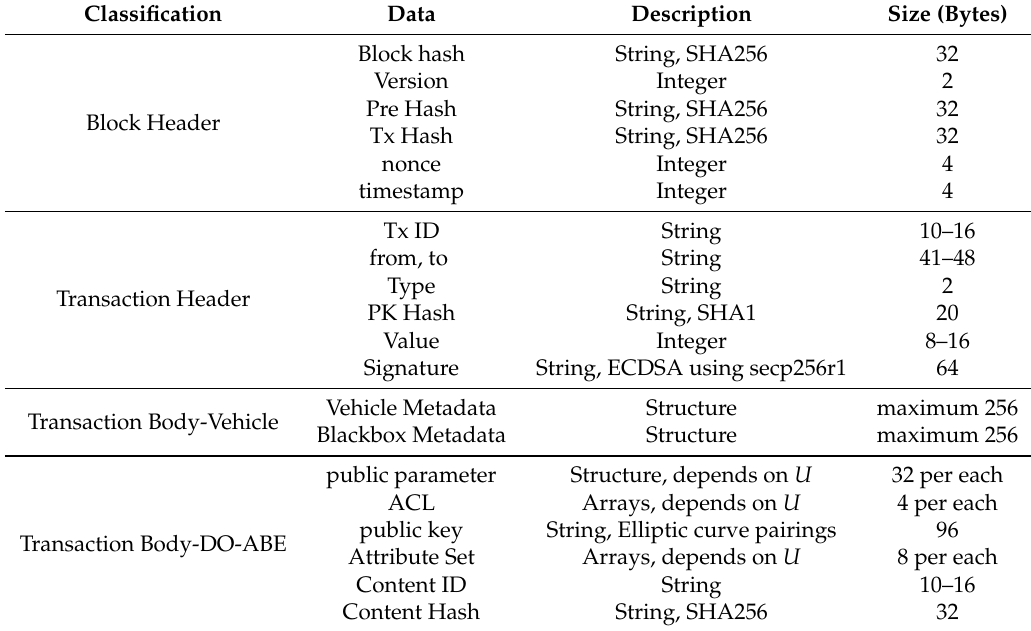
Table 1. Data in Blocks and